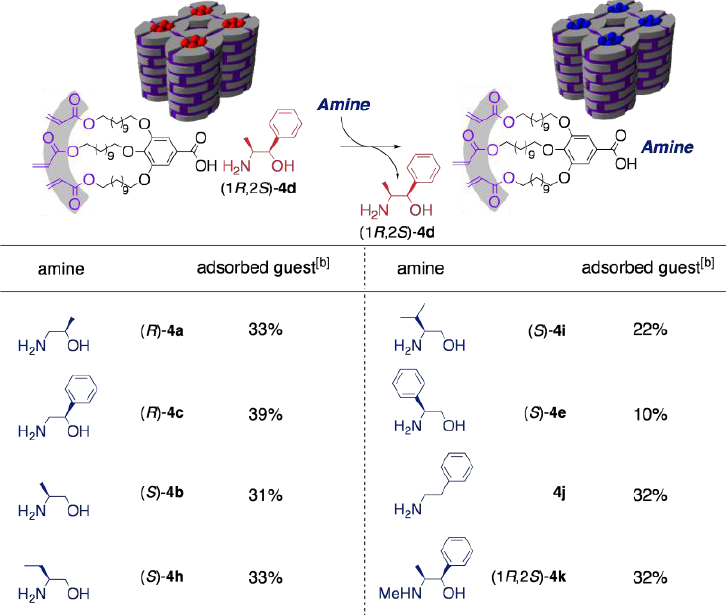
the cross-linked polymer with various amines.